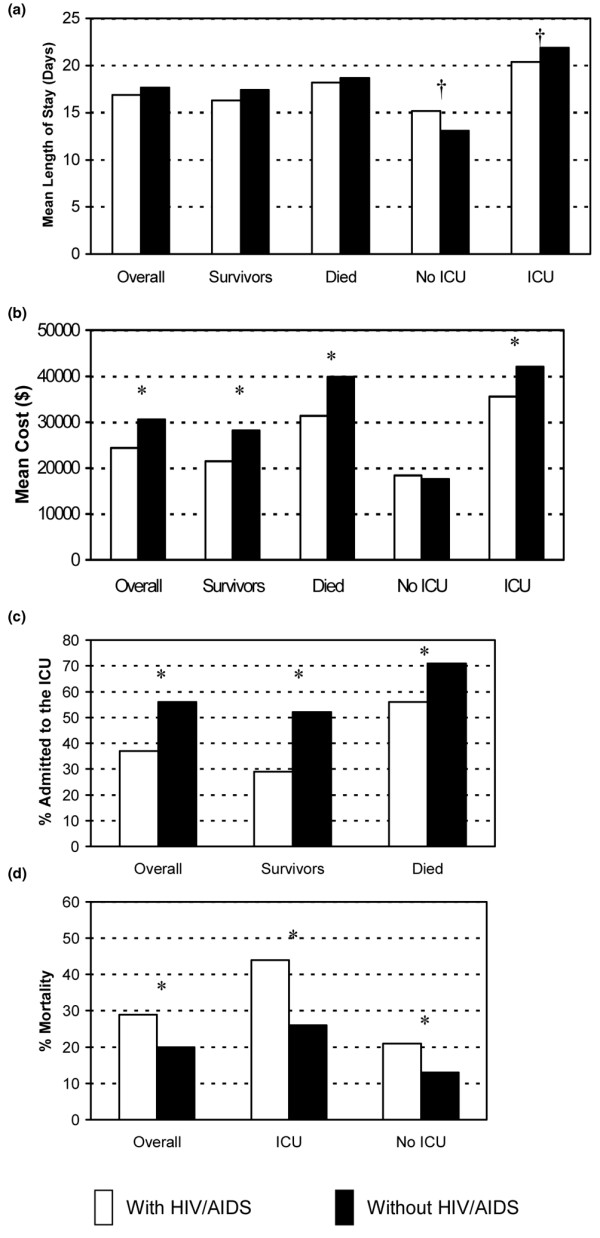
Pattern of care and outcomes for patients with severe sepsis with and without HIV/AIDS. (a) Mean length of stay, (b) mean hospitalization cost, (c) ICU admission rates, and (d) mortality rates are shown. Overall results, as well as results stratified by survival and intensive care unit (ICU) admission are shown (as appropriate). Patients with HIV/AIDS are denoted by the white bars and patients without HIV/AIDS by the black bars.*, p ≤ 0.0001; †, 0.0001 < p ≤ 0.05.